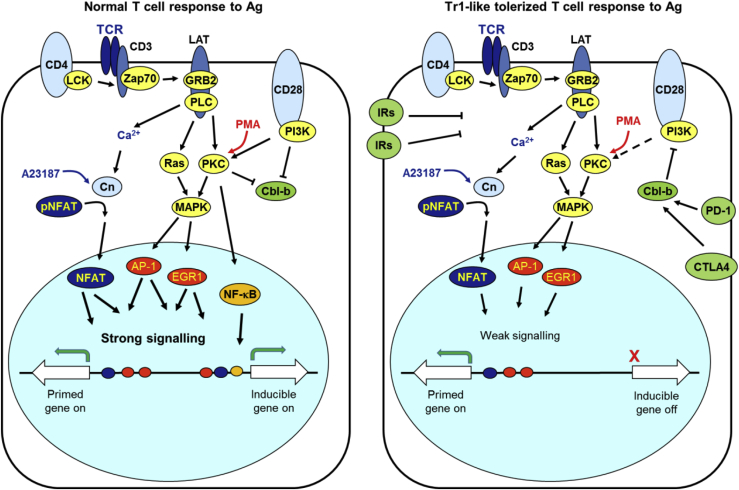
A Two-Step Model Accounting for T Cell ToleranceIn a normal T cell immune response, efficient co-activation of TCR and CD28 signaling leads to strong activation of inducible TFs and immune response genes. In tolerized T cells, inhibitory receptors activate repressive factors, such as the ubiquitin ligase Cbl-b, which weaken but do not eliminate TCR/CD28 signaling. This reduced level of signaling is sufficient to epigenetically prime and activate inhibitory receptor genes, but not most immune response genes.